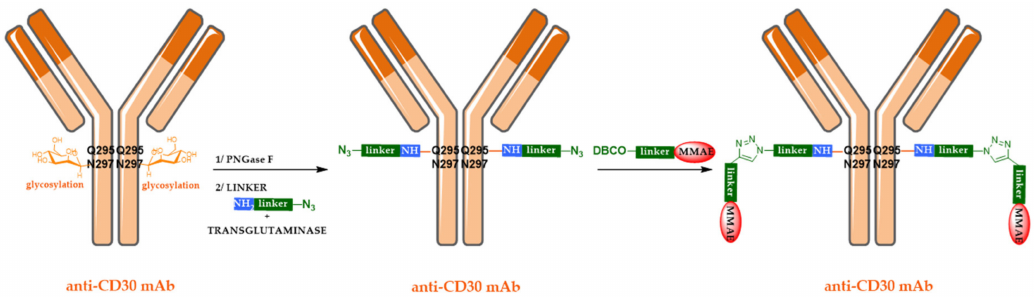
Figure 2. Homogeneous ADCs with a drug-to-antibody ratio (DAR) 2 generated through antibody engineering and site-specific bioconjugation.